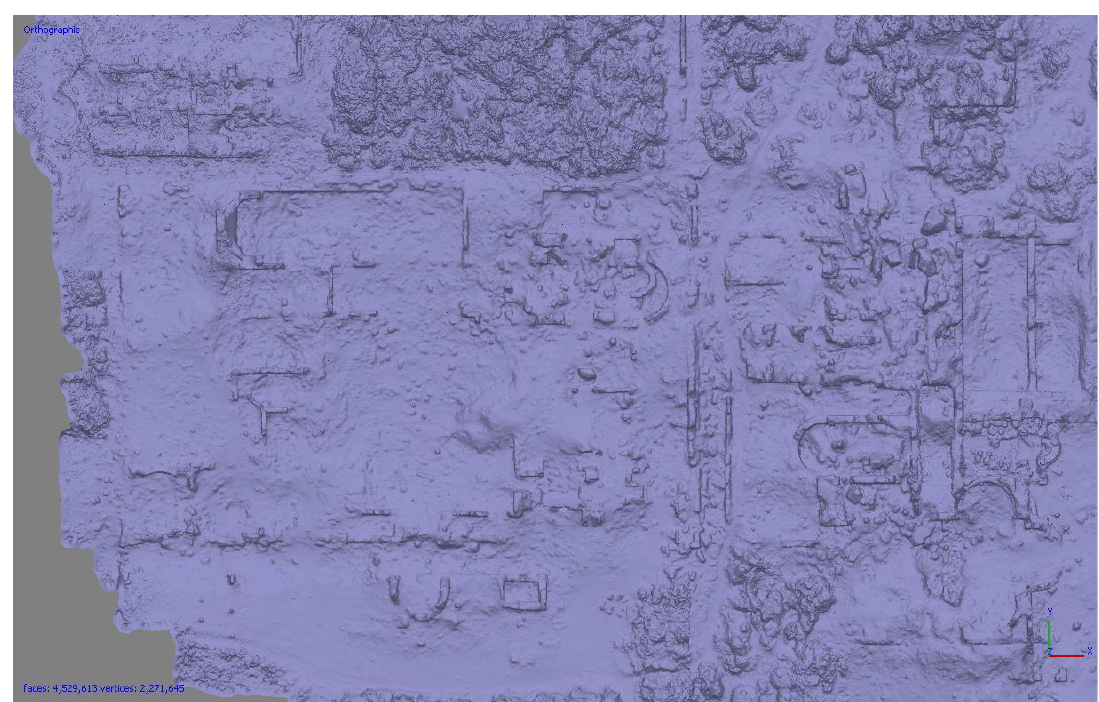
Figure 9.2. TIN view (© M. Hernández